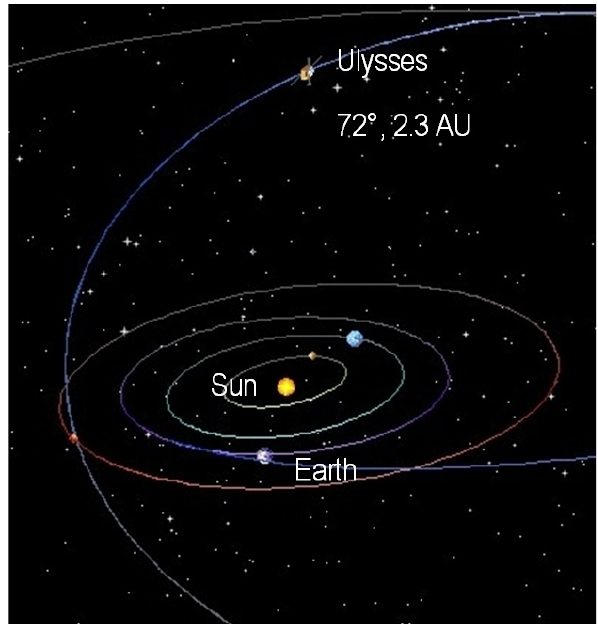
Fig. 6. Relative position of Ulysses and the Earth (ACE) for the events in November